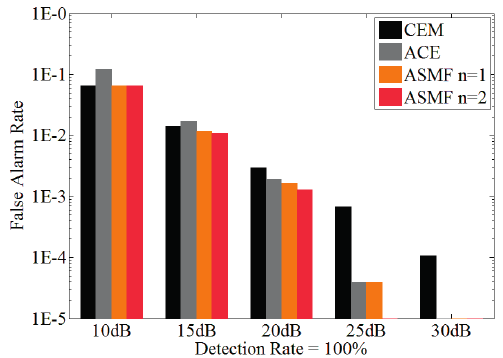
Figure 8. False alarm rate under 100% detection of the synthetic dataset with different degree of white Gaussian noise.